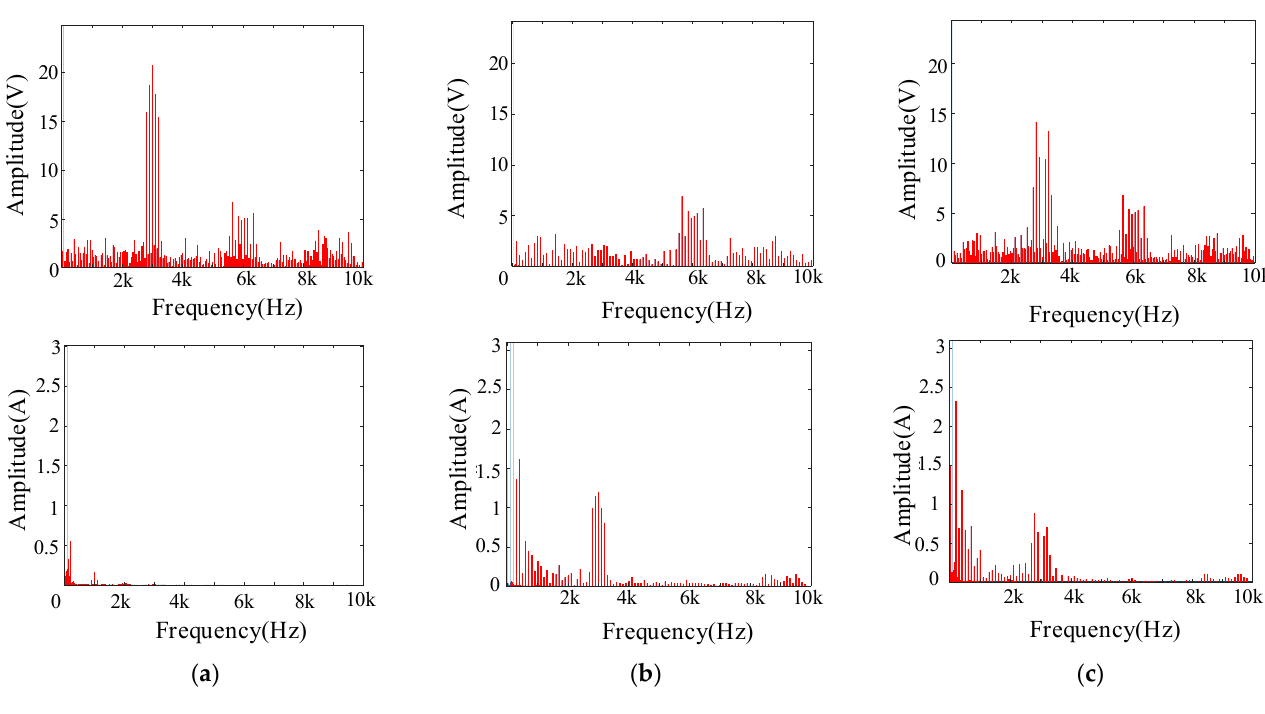
Figure 8. Frequency spectrum of the output voltage and the circulating current when ( a ) θ = π / N , ( b ) θ = 0 or ( c ) SDA-based CPS modulation is adopted. Table 2. The maximum amplitude of the circulating current and the output voltage near frequency Nf c change with θ .